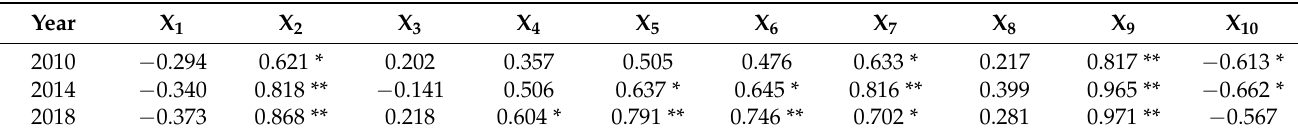
Table 4. Correlation analysis results of factors affecting the distribution of OFDI enterprises in the Yangtze River Economic